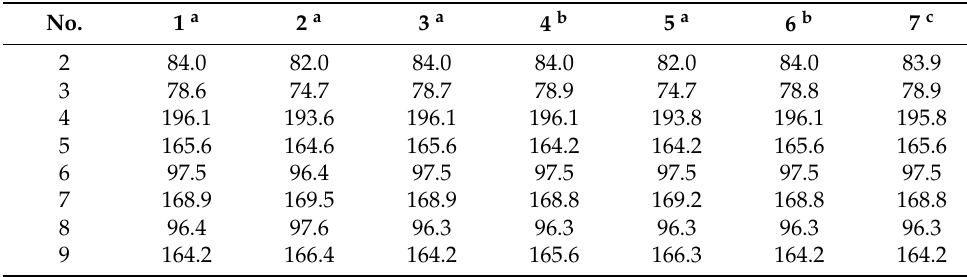
Table 2. 13 C NMR data for compounds 1 – 7 in CD 3 OD ( δ C in ppm).